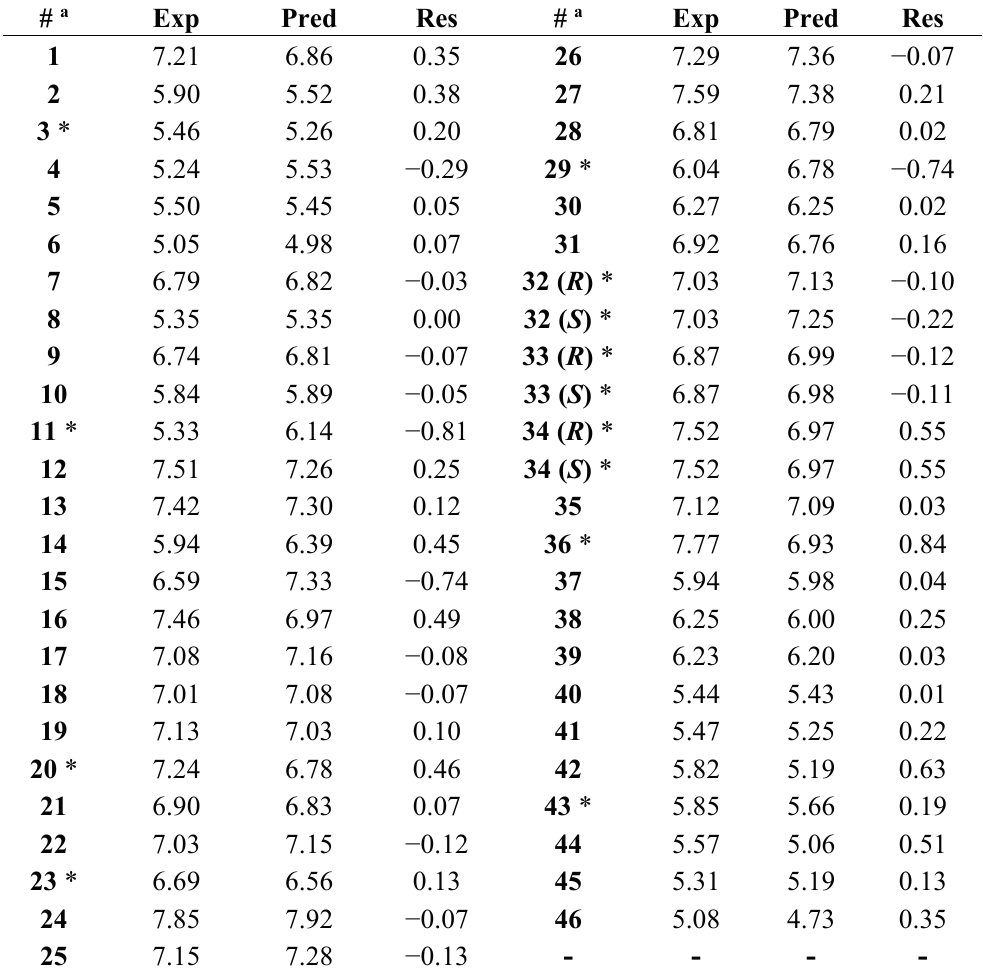
Table 5. Experimental pIC 50 (Exp) and predicted pIC 50 (Pred) biological activities, and residuals (Res = Exp − Pred) of the 6-arylquinazolin-4-amine derivatives using the best HQSAR model with the fragment distinction parameters A/B/C/Ch/DA .